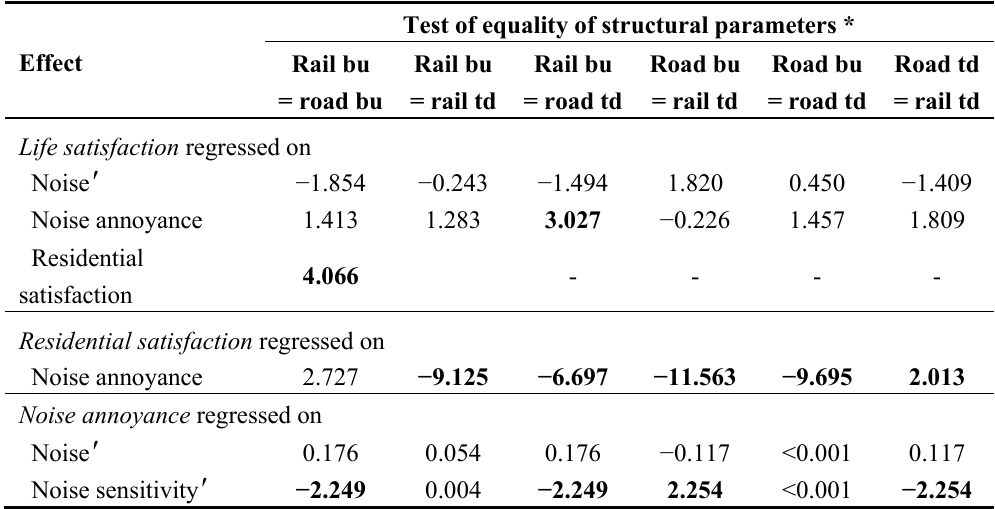
Table 5. Pairwise comparison of structural parameters in the 4